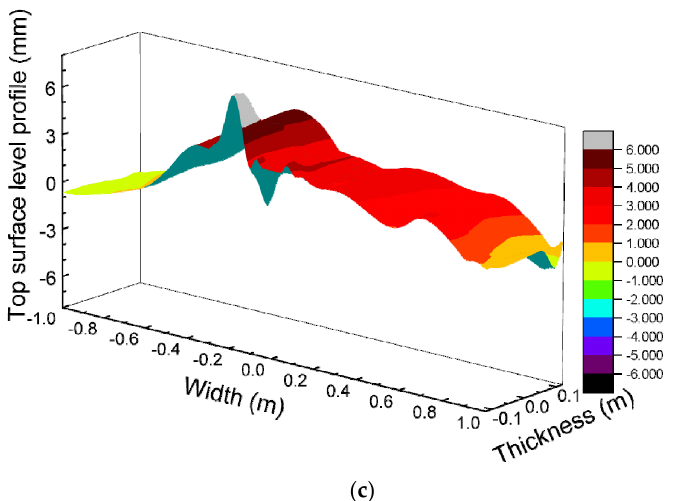
Figure 11. Top surface-level profile of the mold with different widths under high fixed steel throughput: ( a ) 1600 mm, ( b ) 1800 mm, and ( c ) 2000 mm.